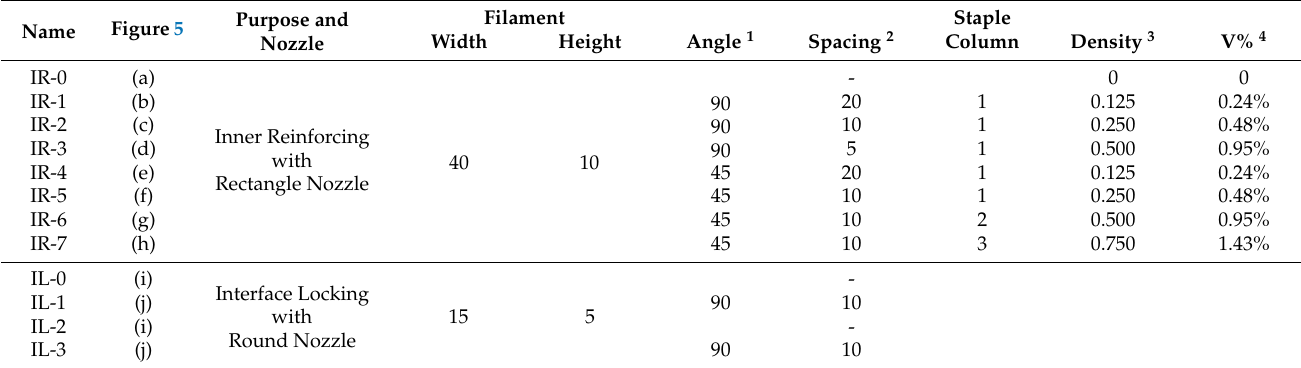
cent staples . 3 — density, the number of staples per cubic centimeter. 4 — v%, volume fraction of the staple in the cement.